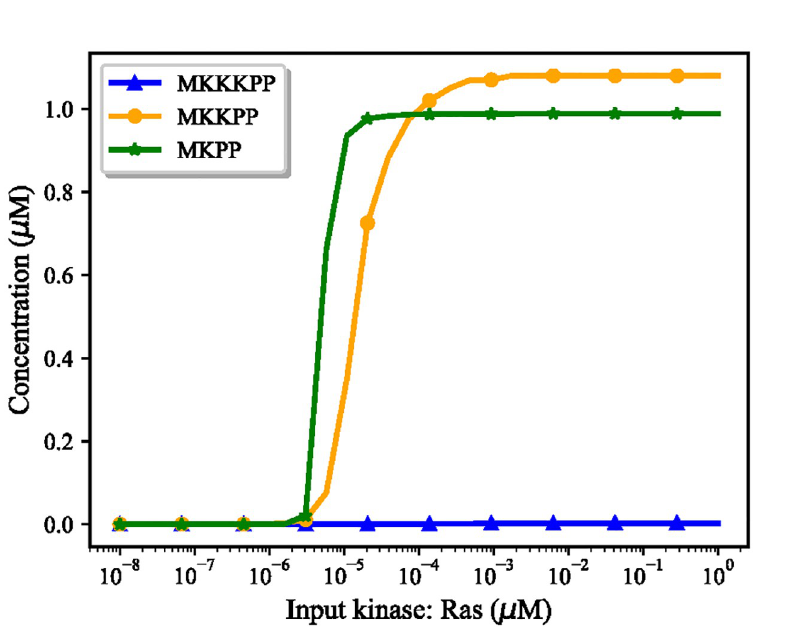
Fig 13. The steady-state responses of the activated kinases for different input amounts in the MAPK cascade model. The input Ras concentration is expressed on a logarithmic scale and each curve is normalised to the maximum reached concentration of that